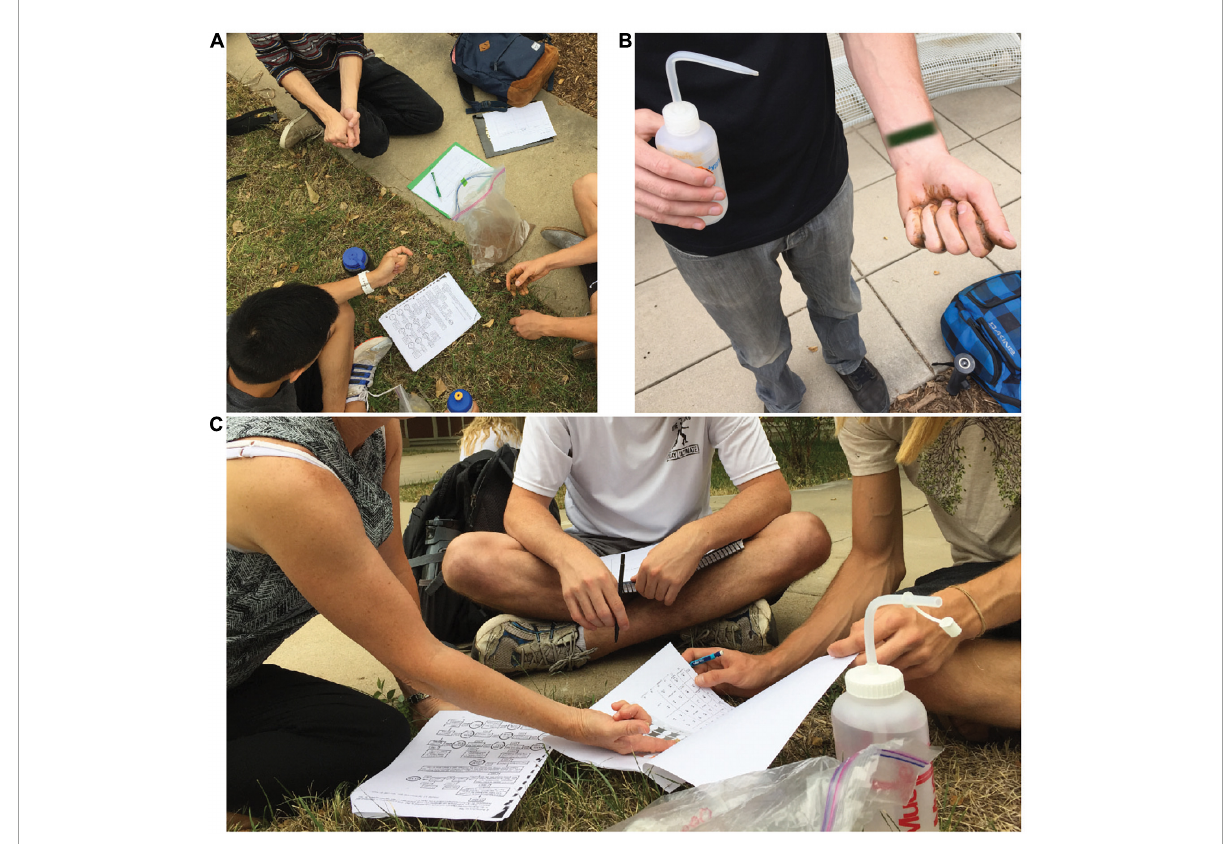
FIGURE1 Undergraduate students (A) work collaboratively to describe several soil unknowns, (B) practice the “texture by feel” method, and (C) determine color analysis of soil unknowns. While these pictures show students learning the techniques in person, they can also be taught effectively using online learning platforms (Photos by E.S.